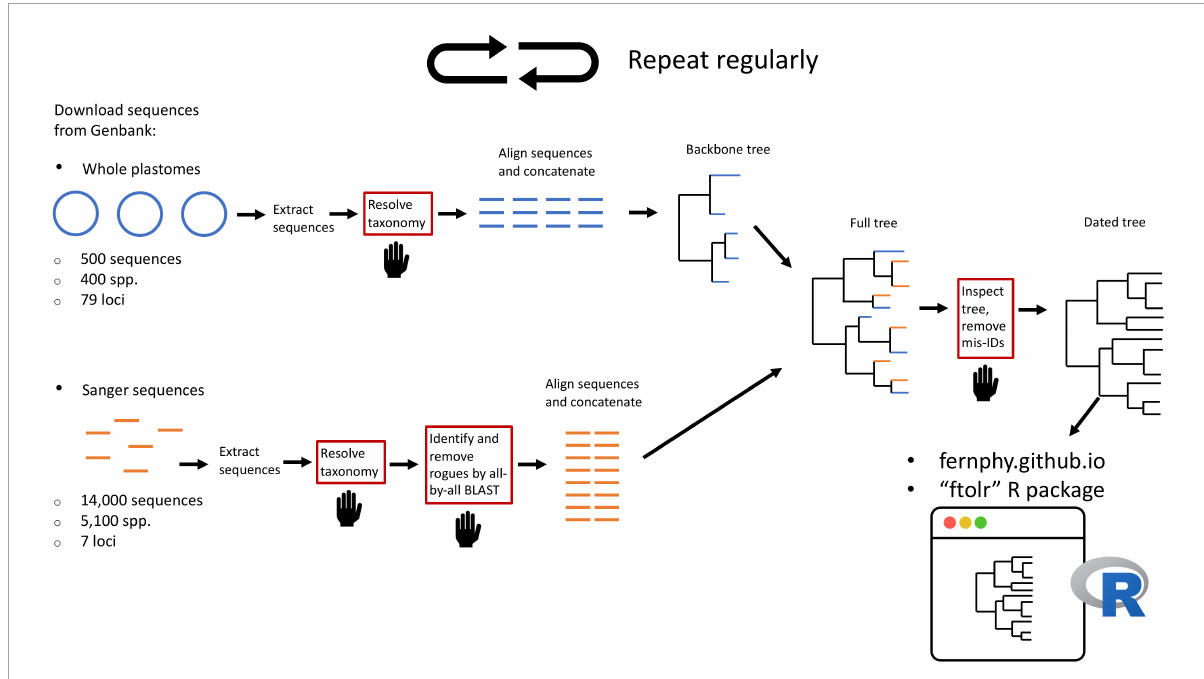
FIGURE2 Summary of workflow to construct the fern tree of life (FTOL). The workflow is automated except for steps in boxes with red outlines and a hand symbol. Numbers of sequences and species are approximate. Sequences originating from whole plastomes are in blue; sequences typically obtained by Sanger sequencing are in orange. For details of each step, see Materials and